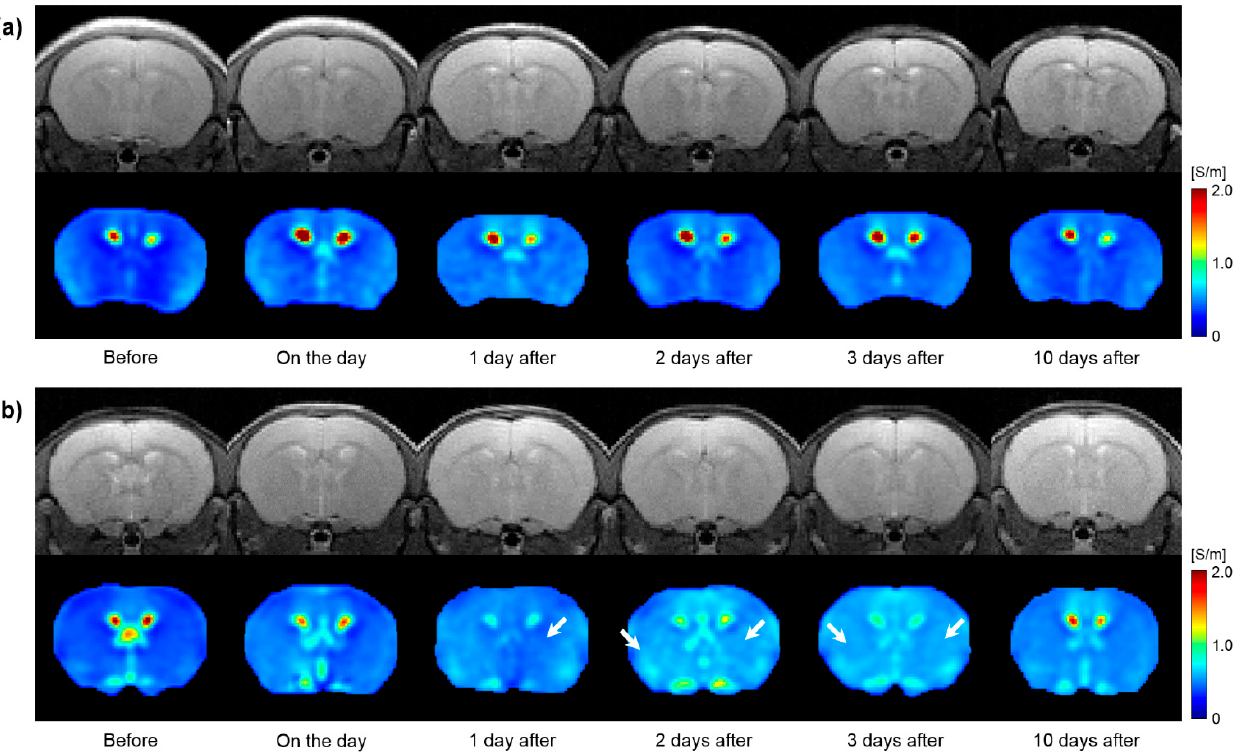
Figure 5. Time-course variations in T2-weighted and electrical conductivity images of in vivo mouse brains in response to 5 Gy ( a ) and 10 Gy ( b ) irradiation doses. White arrows indicate an increase in conductivity